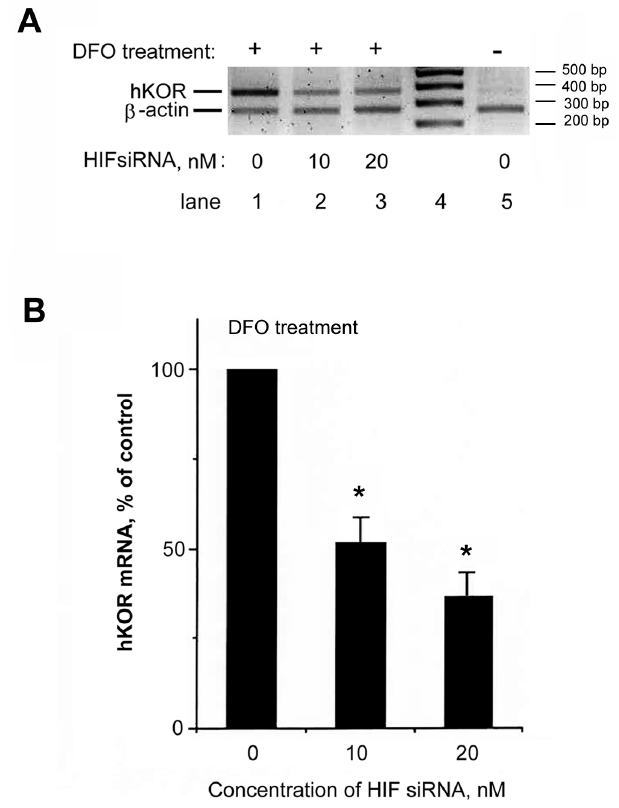
Figure 6. Examination of the effect of hHIF-1 α siRNA on hKOR expression. ( A ) The hHIF-1 α knockdown attenuated DFO-induced enhancement of hKOR expression. NMB cells were transfected with hHIF-1 α siRNA (lane 2, 10 nM; lane 3, 20 nM) or without hHIF-1 α siRNA (0 nM; lanes 1 and 5). Twenty-four hours after transfection, cells were treated without (lane 5, − ) or with DFO for 24 h (lanes 1–3, +). Semi-quantitative RT-PCR was performed using a pair of primers specific to hKOR with β -actin specific primers as the internal standard for normalization. PCR products were analyzed using gel electrophoresis. Lane 4: DNA markers (each maker was labeled on the right-hand side); ( B ) quantitation of hKOR mRNA levels is shown, with the normalized hKOR mRNA level from the DFO treated sample without siRNA as 100%. The hHIF-1 α siRNA treatment significantly diminished the DFO-induced increase of endogenous hKOR mRNA. Histograms represent mean ± S.E.M. Experiments were repeated eight times. Asterisk “*” indicates p < 0.01 ( t -test).